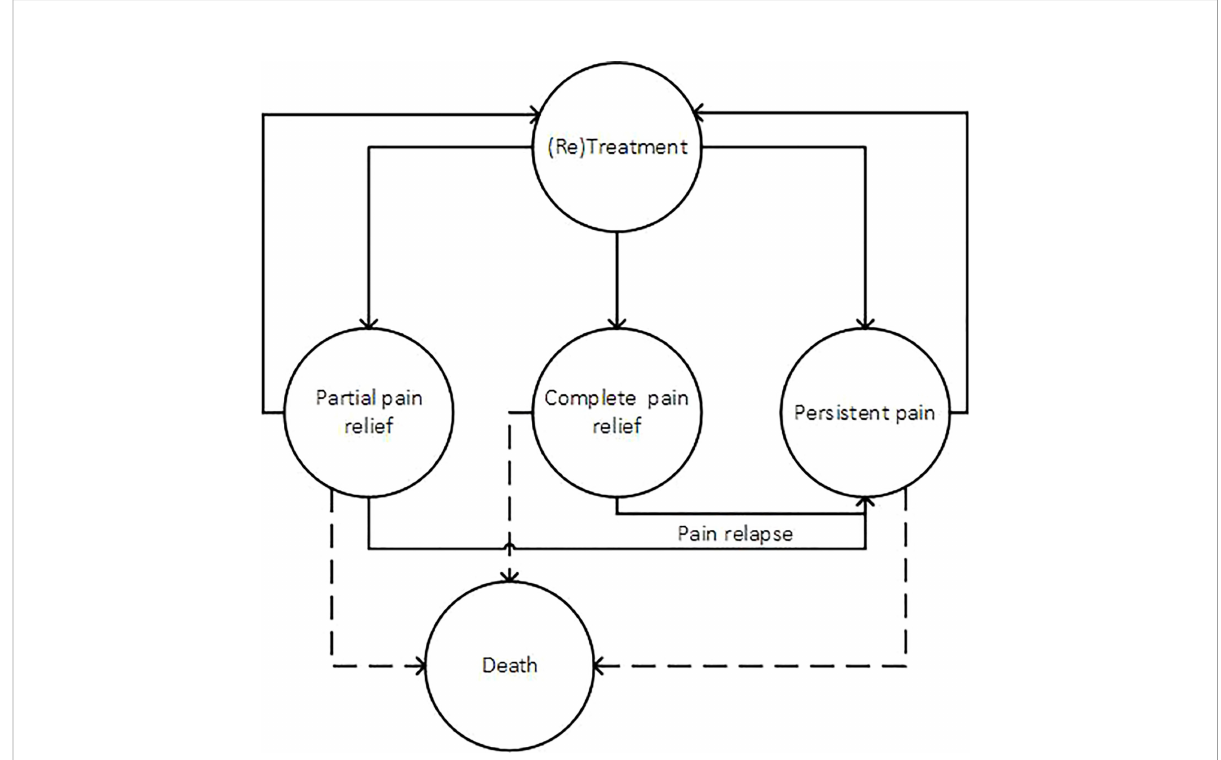
FIGURE 2 Model overview. Patients enter the model after treatment with either EBRT or MR-HIFU. Pathological fracture was modelled as an event that could occur in each cycle and health state (except